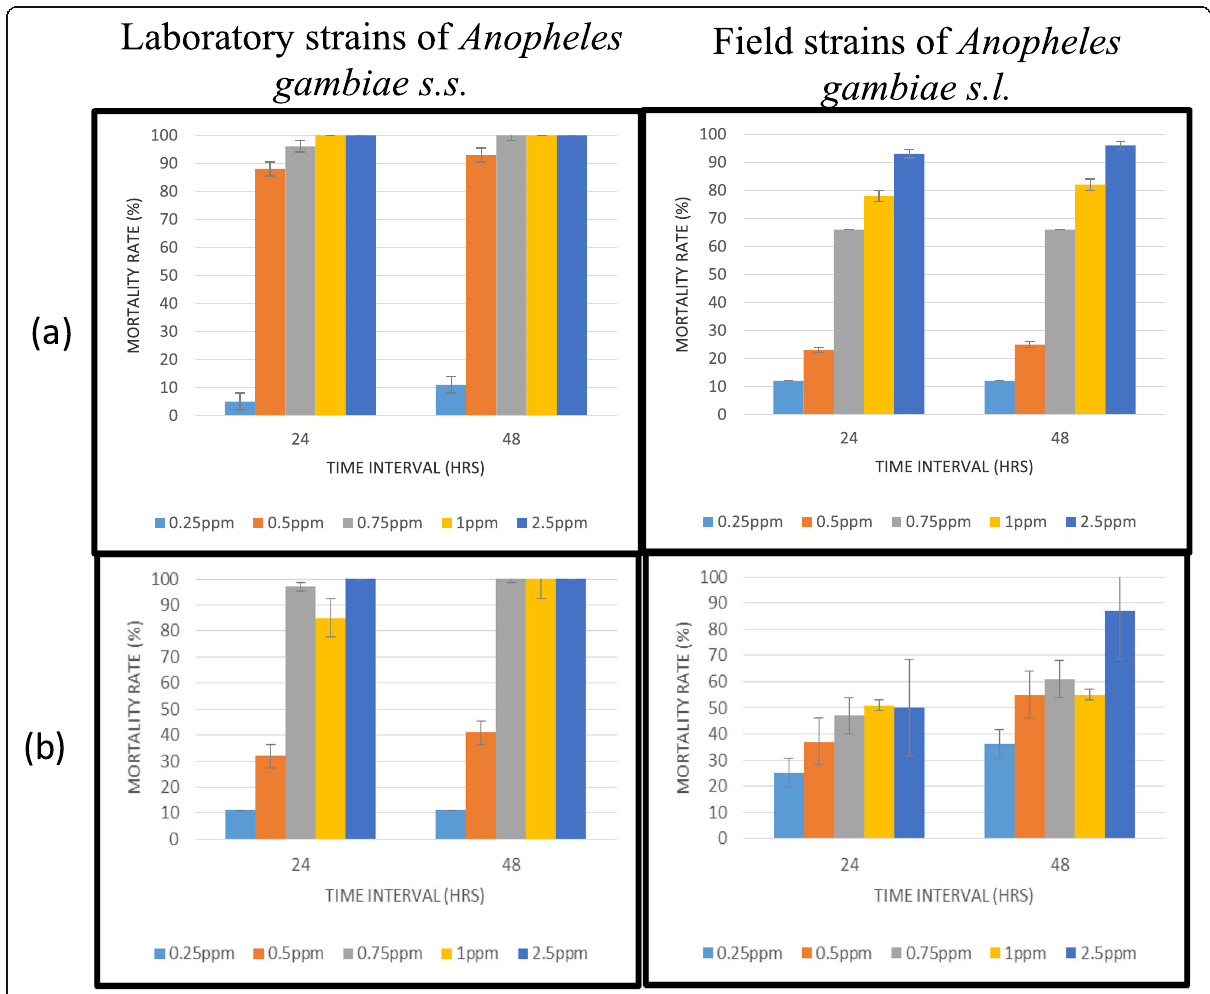
Fig. 7 Larval mortality of laboratory and field strains of Anopheles with synthesized AgNPs of a Moringa oleifera and b Ficus